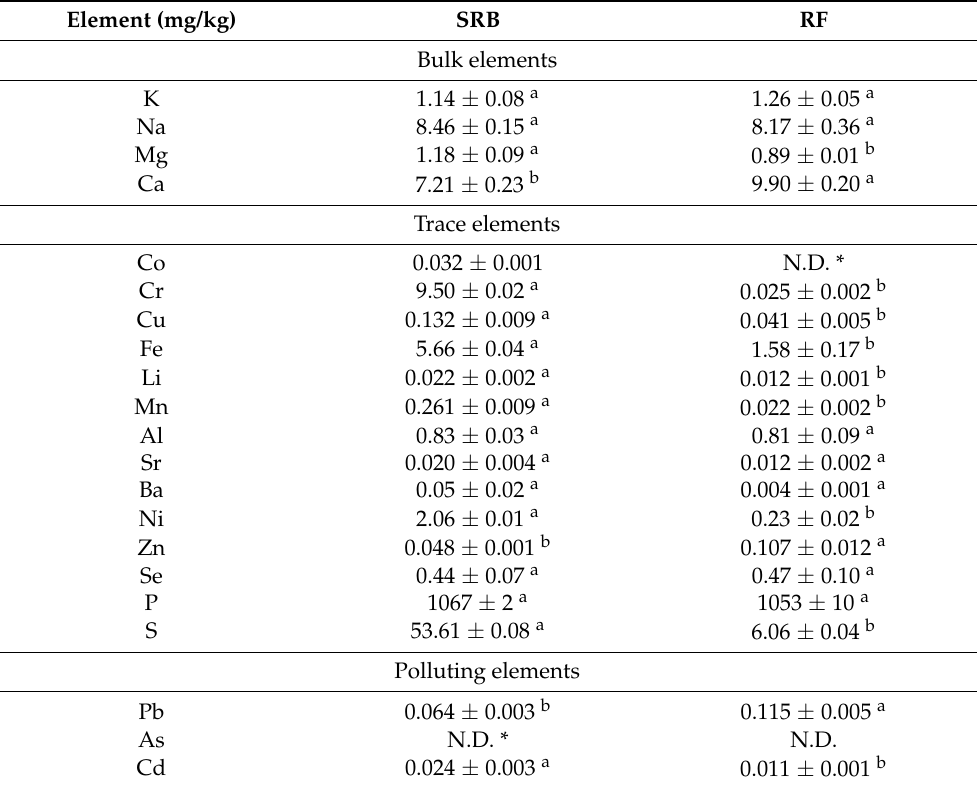
Table 2. Elements and minerals in Serbian (SRB) and Russian (RF) essential